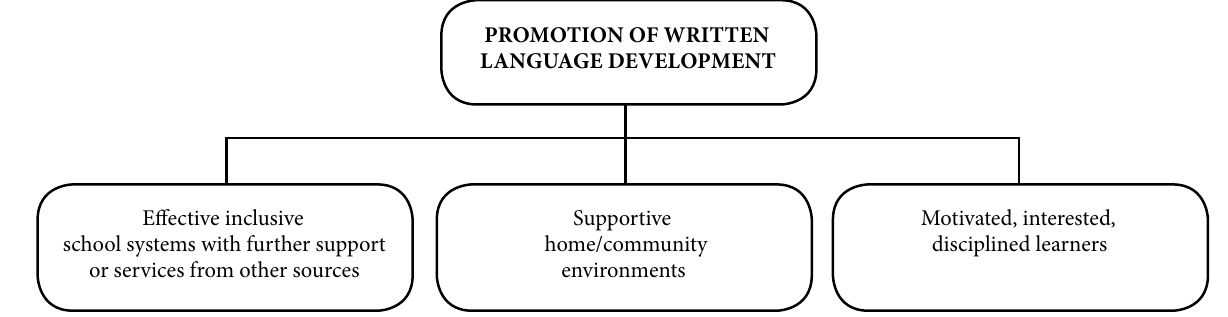
Fig. 1. Summary of factors promoting written language development in ordinary linguistically diverse